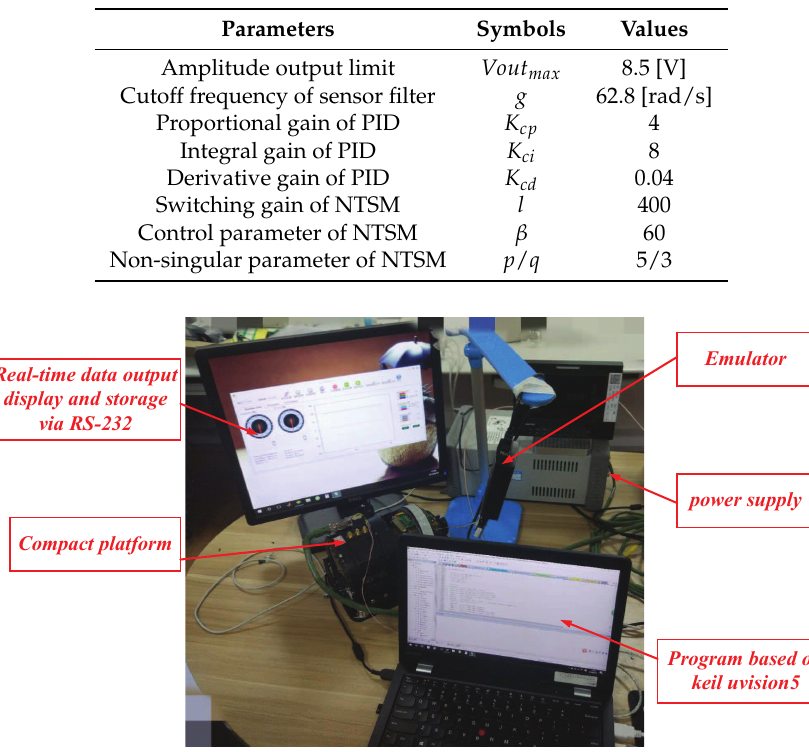
Figure 7. Experimental